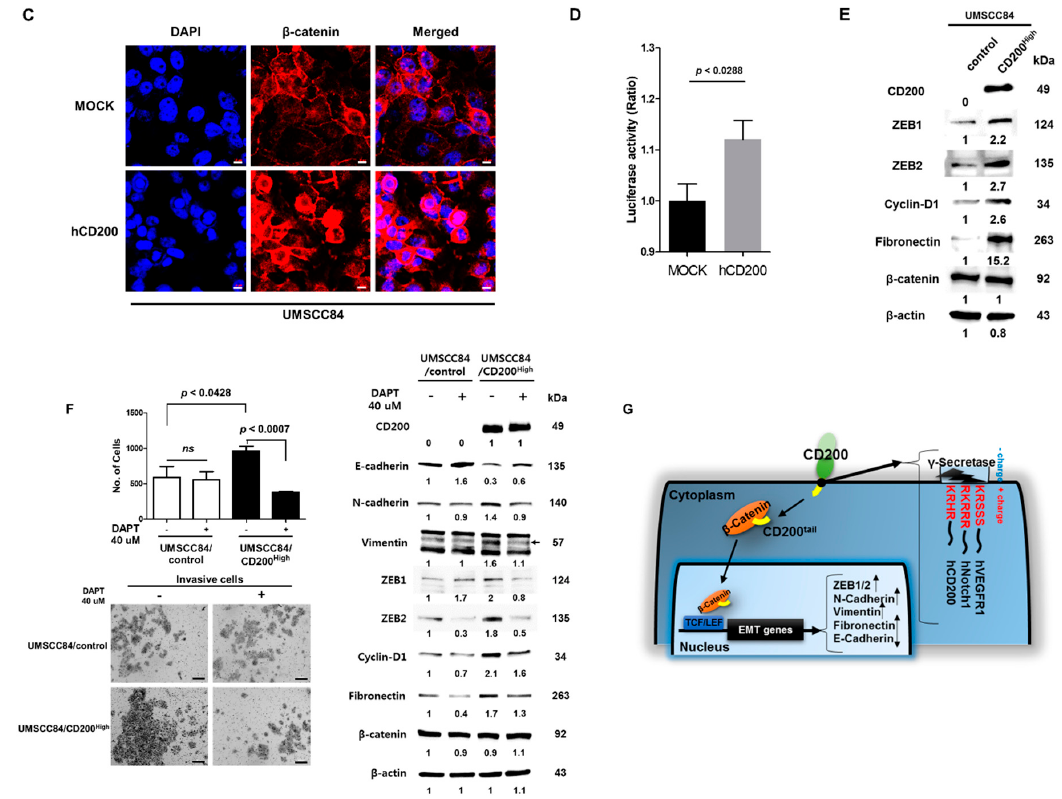
Figure 4. Cytoplasmic domain of CD200 interacted with β -catenin, induced the translocation of β -catenin in the nucleus, and increased EMT-related gene expression. ( A ) The interaction between the 3X-FLAG-tagged cytoplasmic domain of CD200 with β -catenin was investigated by transfecting the human CD200 overexpression vector into UMSCC84 cells, followed by immunoprecipitation. ( B ) CD200-FLAG and β -catenin levels were analyzed using Western blotting after preparing nuclear and cytosolic lysates from CD200 -transfected UMSCC84. Lamin A/C and GAPDH were used as nuclear and cytosolic markers, respectively. ( C ) Detection in expression and localization of β -catenin in Flag-E.V or Flag-CD200 transfected into MEER cells. Immunocytochemistry were performed with anti- β -catenin Alexa flour 647 (red) followed by DAPI nuclear counterstainging (Blue) were detected by confocal microscopy. The bar indicates 10 µm. ( D ) TCF/LEF-luciferase activity was measured in UMSCC84 cells transfected with CD200 overexpression vector for 24 h. ( E ) UMSCC84 cells (1 × 10 5 ) were cultured in 6-well plates for 48 h. The cell lysates (30 µg) were analyzed using Western blotting. ( F ) UMSCC84 cells (1 × 10 5 ) were seeded in Matrigel-coated Transwell in the presence of 40 µM γ -secretase inhibitor for 48 h. Each error bar in the graph represents the average of three independent experiments (mean ± SEM). The cell lysates (30 µg) by γ -secretase inhibitor were analyzed using Western blotting. ( G ) The CD200 cytoplasmic domain is cleaved by γ -secretase within the transmembrane, which binds to β -catenin in the cytoplasm and is translocated into the nucleus. The anterior amino acids of the cytoplasmic tail of hVEGFR1, hNOTCH, and hCD200, which are cleaved by γ -secretase, have common positive charge (red color).